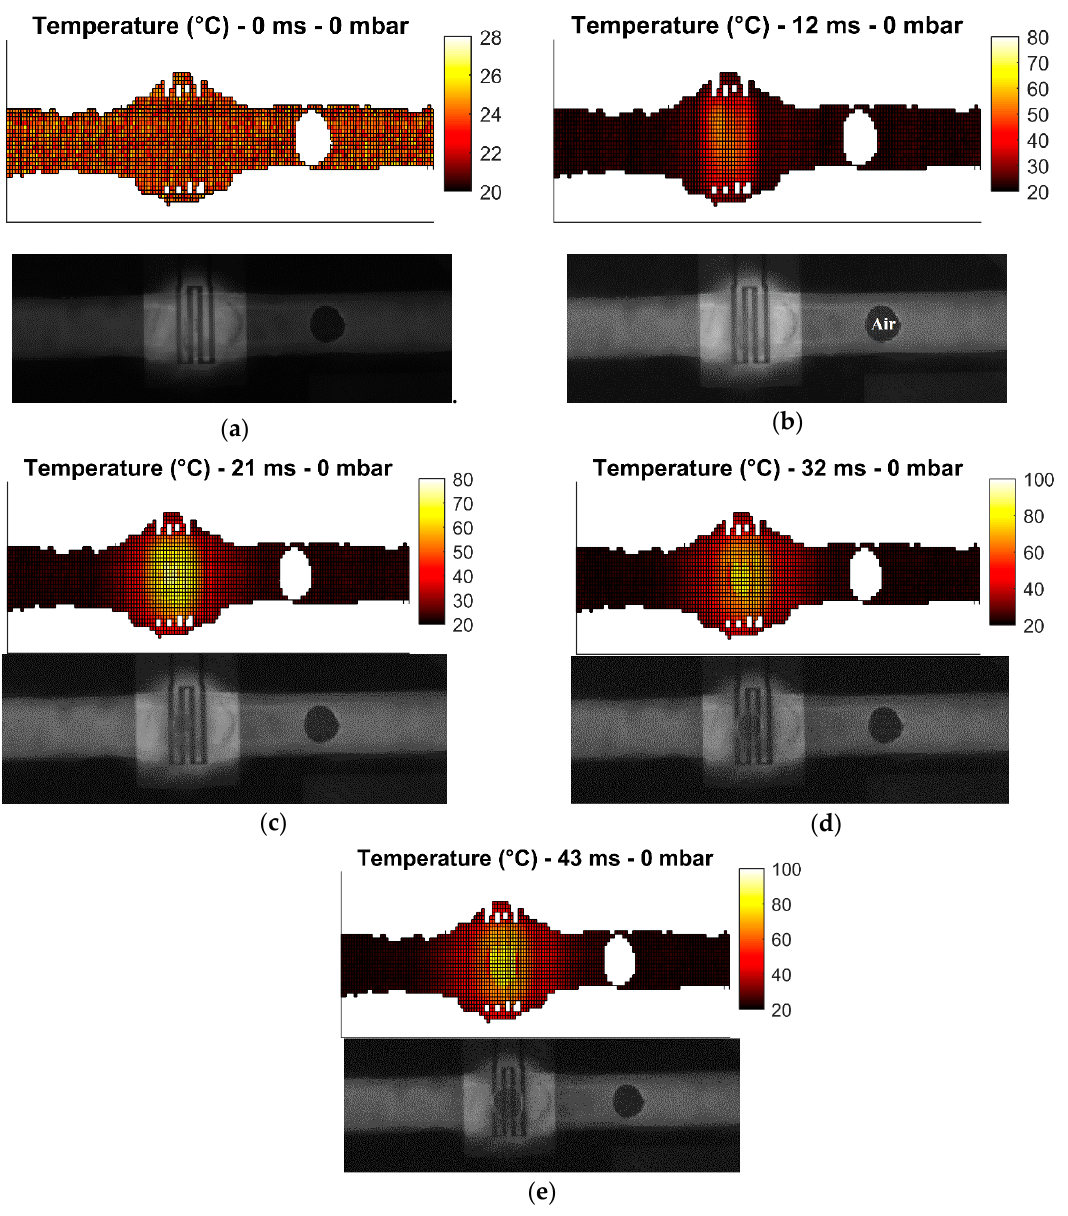
Figure 9. Measured temperature profile (top) of the fluorescent mixture in the channel with the corresponding image (bottom) from the camera for the pressure difference of 0 mbar after: ( a ) prior to heating; ( b ) 12 ms heating started; ( c ) 21 ms heating started; ( d ) 32 ms heating started; ( e ) 43 ms heating started.